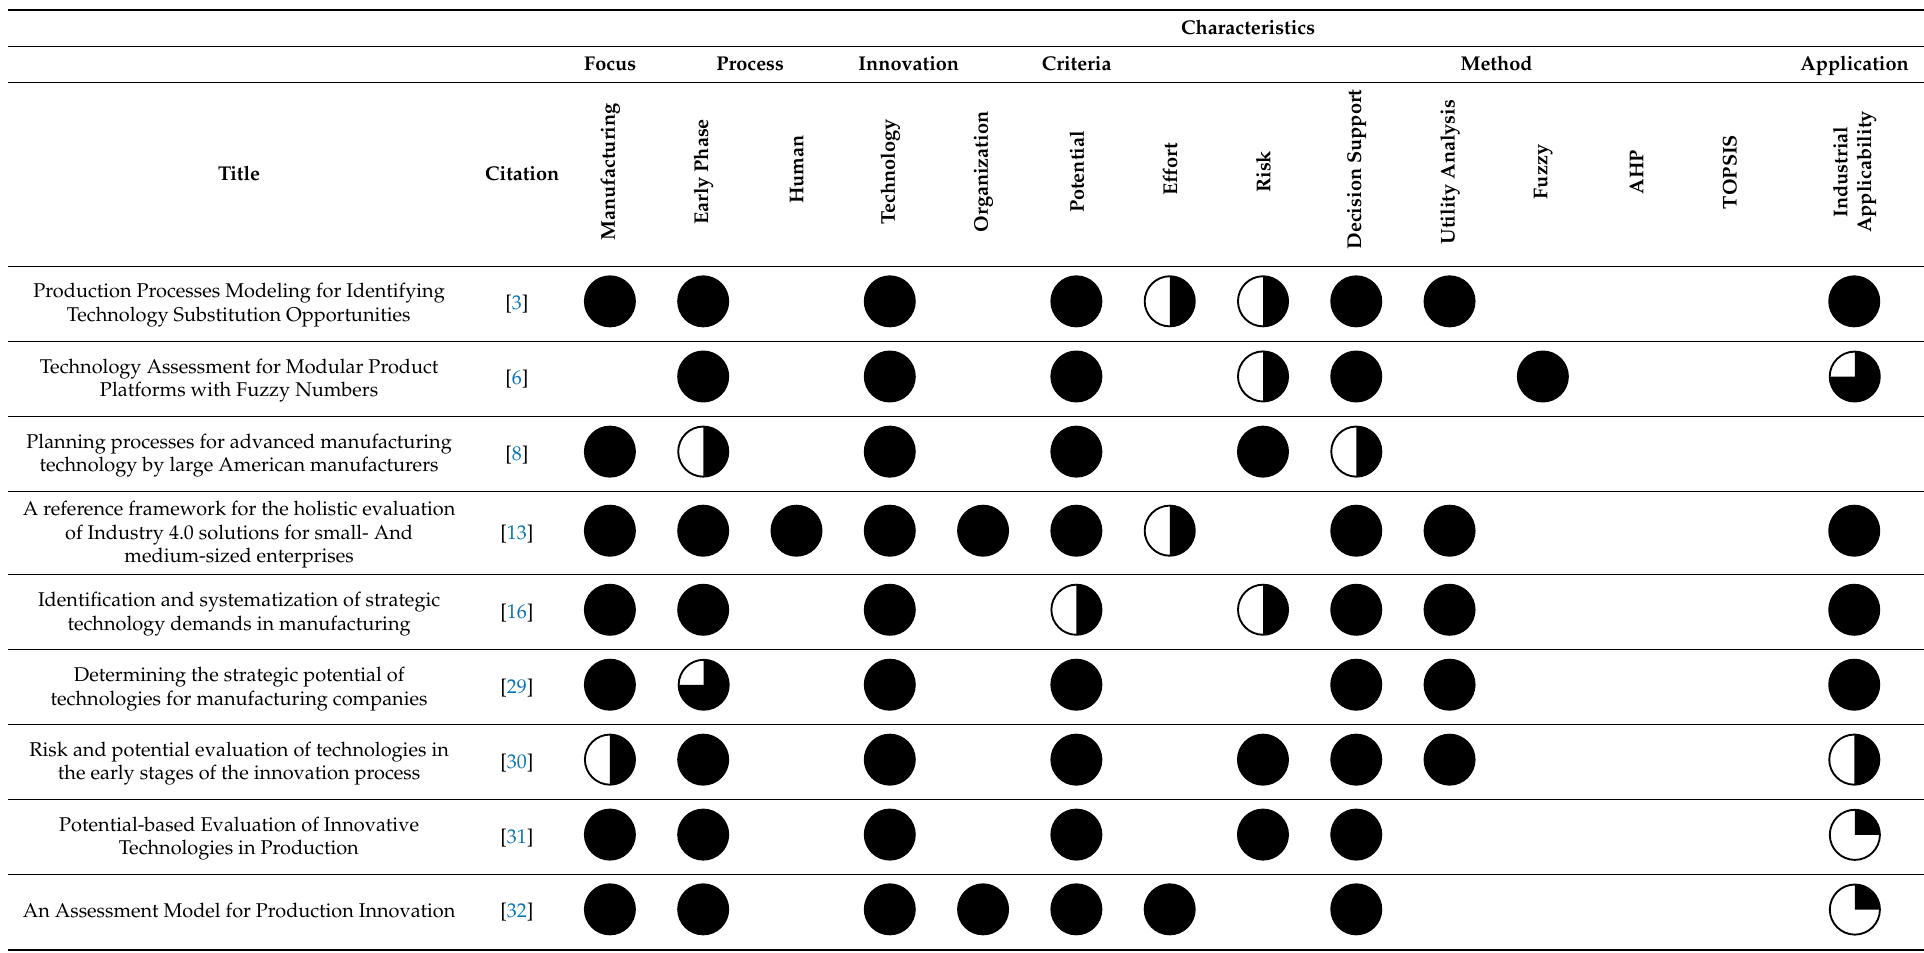
Characteristics